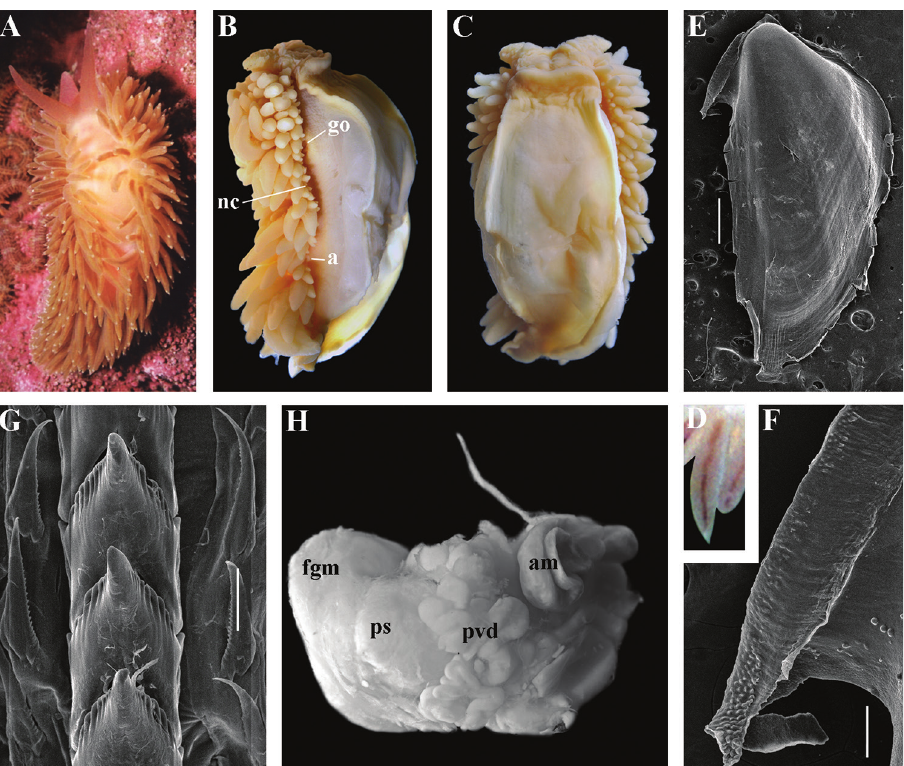
Figure 15. Ziminella salmonacea (Cothouy, 1839), comb. n.: A living animal (Spitzbergen), dorsal view B preserved animal, lateral view ZMMU Op-265, 19 mm preserved C same, ventral view D details of cerata E jaw, SEM F details of masticatory process of jaw, SEM G radular teeth, posterior part, SEM H reproductive system, light microscopy. Abbreviations: a anus am ampulla fgm female gland mass go genital opening nc continuous notal edge ps penial sheath pvd prostatic vas deferens. Scale bars: E = 300 μm; F = 30 μm; G bar = 100 μm. Photos of living specimens by B. Gulliksen, other photos and SEM images by A.V.